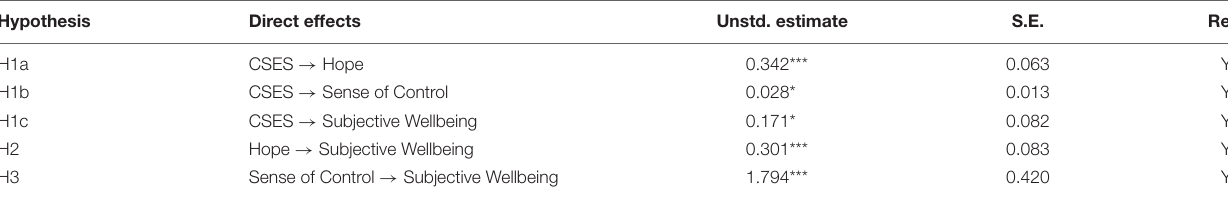
TABLE 5 | The direct effects results of mediation